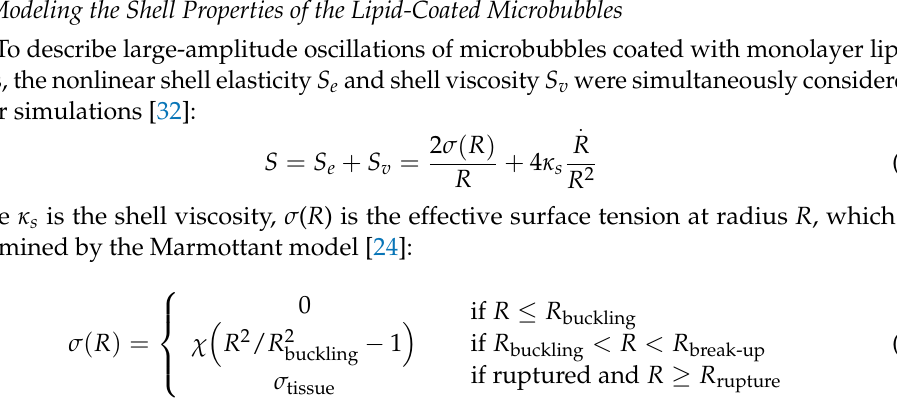
Figure 1. Schematic of the cavitation dynamics for two interacting lipid-coated microbubbles in viscoelastic tissues.